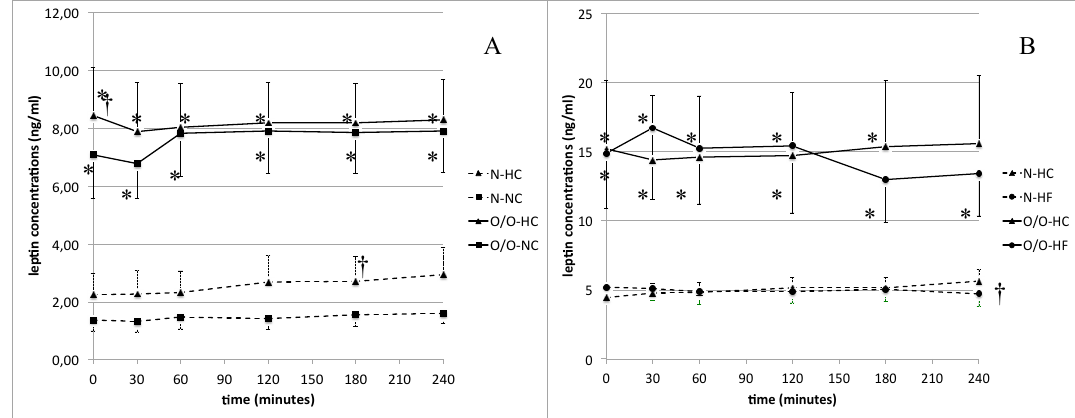
Figure 1. ( A ) Adiponectin concentrations (ng/mL) in men with normal body weight (N, the broken line) and overweight/obese people (O/O, the solid line) in fasting state (time 0 min) and after consumption (time 30 – 240 min) of a high carbohydrate meal (HC) and a normal carbohydrate meal (NC). The results are presented as mean values ± SE. * The comparison between study groups N and O/O , p < 0.05. † The comparison between meals HC and NC , p < 0.05. ( B ) Adiponectin concentrations (ng/mL) in men with normal body weight (N, the broken line) and overweight/obese people (O/O, the solid line) in fasting state (time 0 min) and after consumption (time 30 – 240 min) of a high carbohydrate meal (HC) and a high fat meal (HF). The results are presented as mean values ± SE. * The comparison between study groups N and O/O , p < 0.05 . † The comparison between meals HC and HF, p < 0.05. In normal body weight participants, we observed significantly higher ( p = 0.01) leptin concentrations 180 min after HC-meal than after NC-meal intake (Figure 2A). In overweight/obese men, although leptin concentrations before the HC-meal were significantly higher (8.44 ± 1.68 vs. 7.07 ± 1.51 ng/mL, p = 0.01), postprandially we did not observe any significant differences. The AUC for postprandial leptin levels was significantly higher after the HC-meal intake than after the NC-meal (670 ± 220 vs. 391 ± 103, p = 0.04) in the N group. When we compared the postprandial leptin levels between the HC and HF-meals, we found that men with normal body weight showed a tendency, which was on the margin of significance ( p = 0.05), to higher leptin concentrations 240 min after the HC-meal intake (Figure 2B). In overweight/obese subjects, we did not observe any significant differences in postprandial leptin concentrations dependent on meal type. Leptin levels in O/O men were significantly higher than in N subjects, at fasting state and during the further 4 h of all of the meal challenge tests (Figure 2A,B).